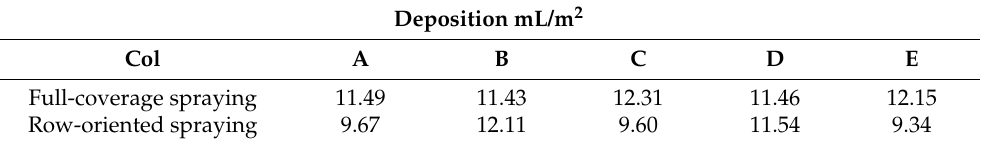
Table 4. Deposition